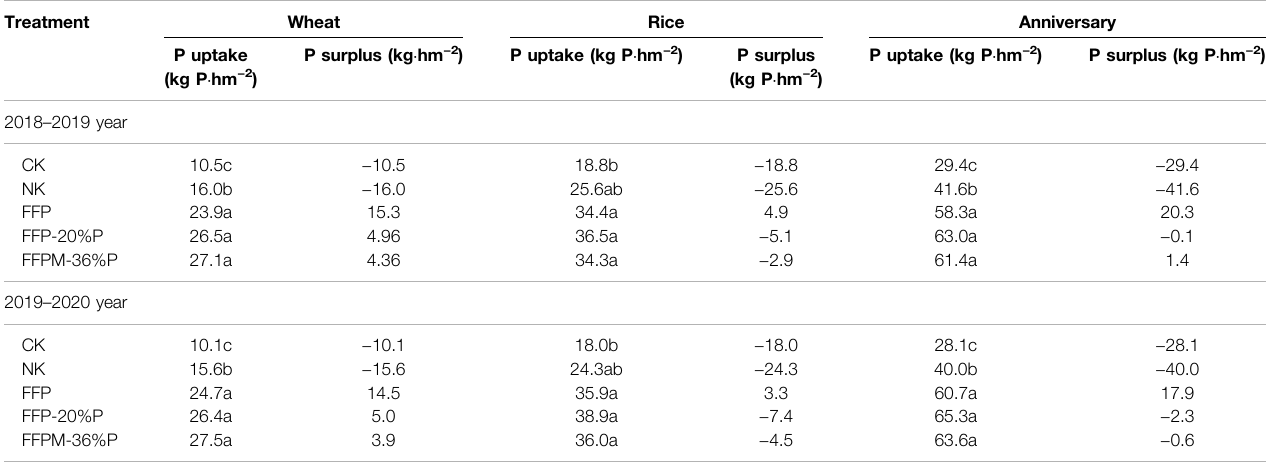
TABLE 7 | Effect of optimized fertilization on P uptake and P surplus. Treatment Wheat Rice